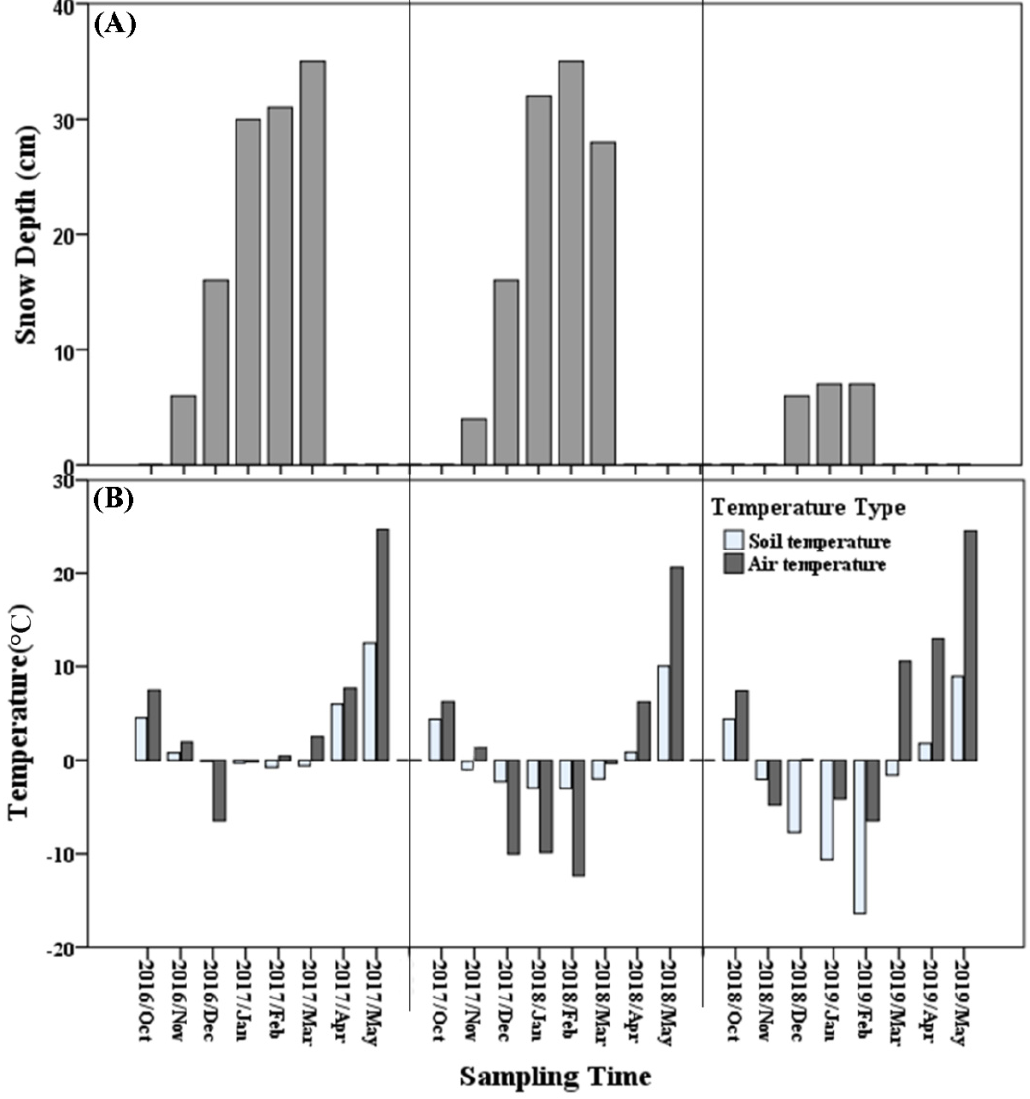
Figure 1. The ( B ) air temperature, soil temperature at 5 cm depth, and ( A ) snow depth during the Figure 1. The air temperature, soil temperature at 5cm depth, and snow depth during the measurement measurement periods.